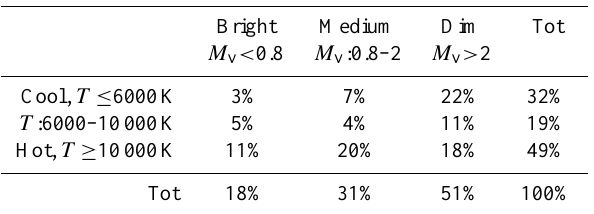
Fig. 3. The average signal-to-noise ratio for three stars as a func- tion of altitude in 2003. Star 1, bright ( M v = − 1.44) and hot star ( T = 11000K, solid line with circles) Star 4, bright and cool star ( M v = − 0.01, T = 5800K, solid line) and star 117, dim and cool star ( M v =2.7, T = 3800K, dashed line). Blue lines correspond to av- eraged SNR at UV: 250–350nm, red line averaged SNR at VIS: 420–550nm and green line averaged SNR at VIS: 550–675nm. Table 1. Occultation statistics during time period 2002–2008 di- vided by different stellar classes depending on brightness and ap- proximated surface temperature.